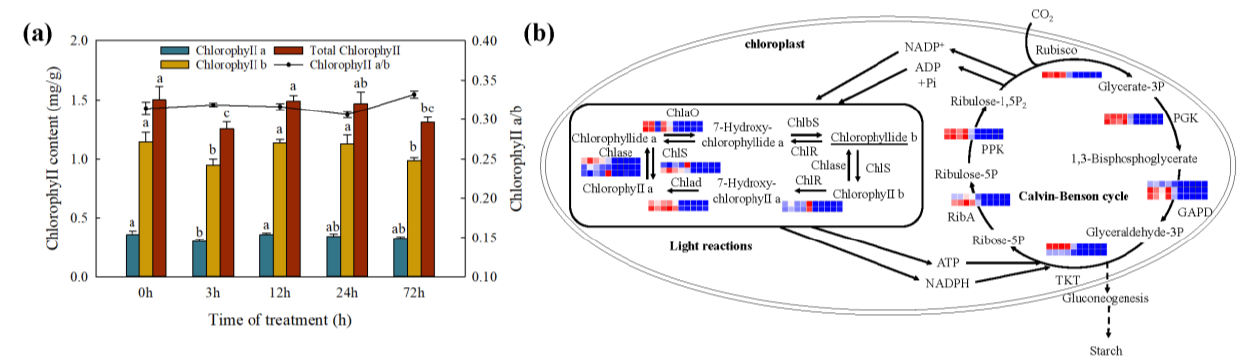
Figure 9. The change of ( a ) chlorophyll contents, and different letters (a, b, c) in the figures indicate significant differences at p < 0.05 level among different time points in the same parameter; ( b ) the expression levels of the photosynthetic related genes under Cd stress.